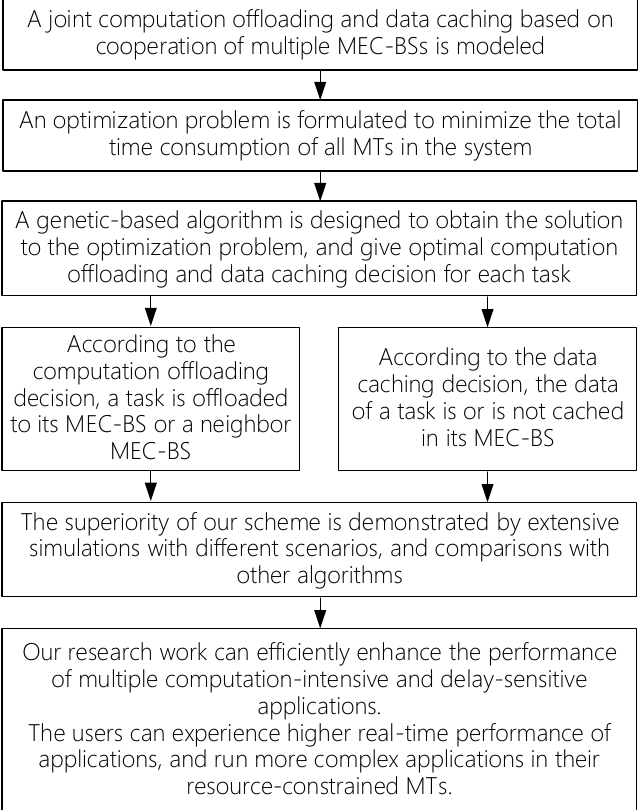
Figure 2. Brief introduction of the research work in our